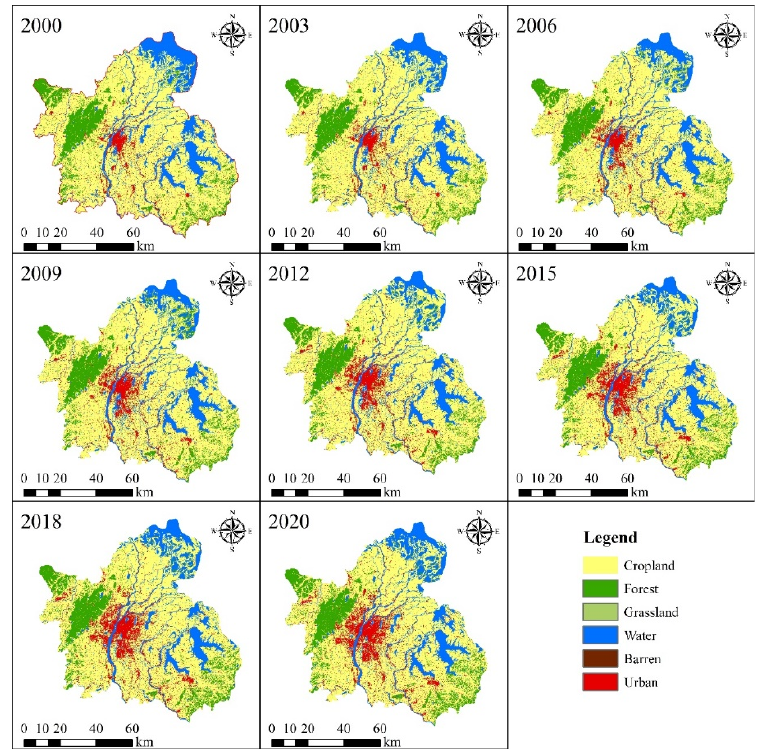
Figure 3. Nanchang City Land Use Map 2000–2020.